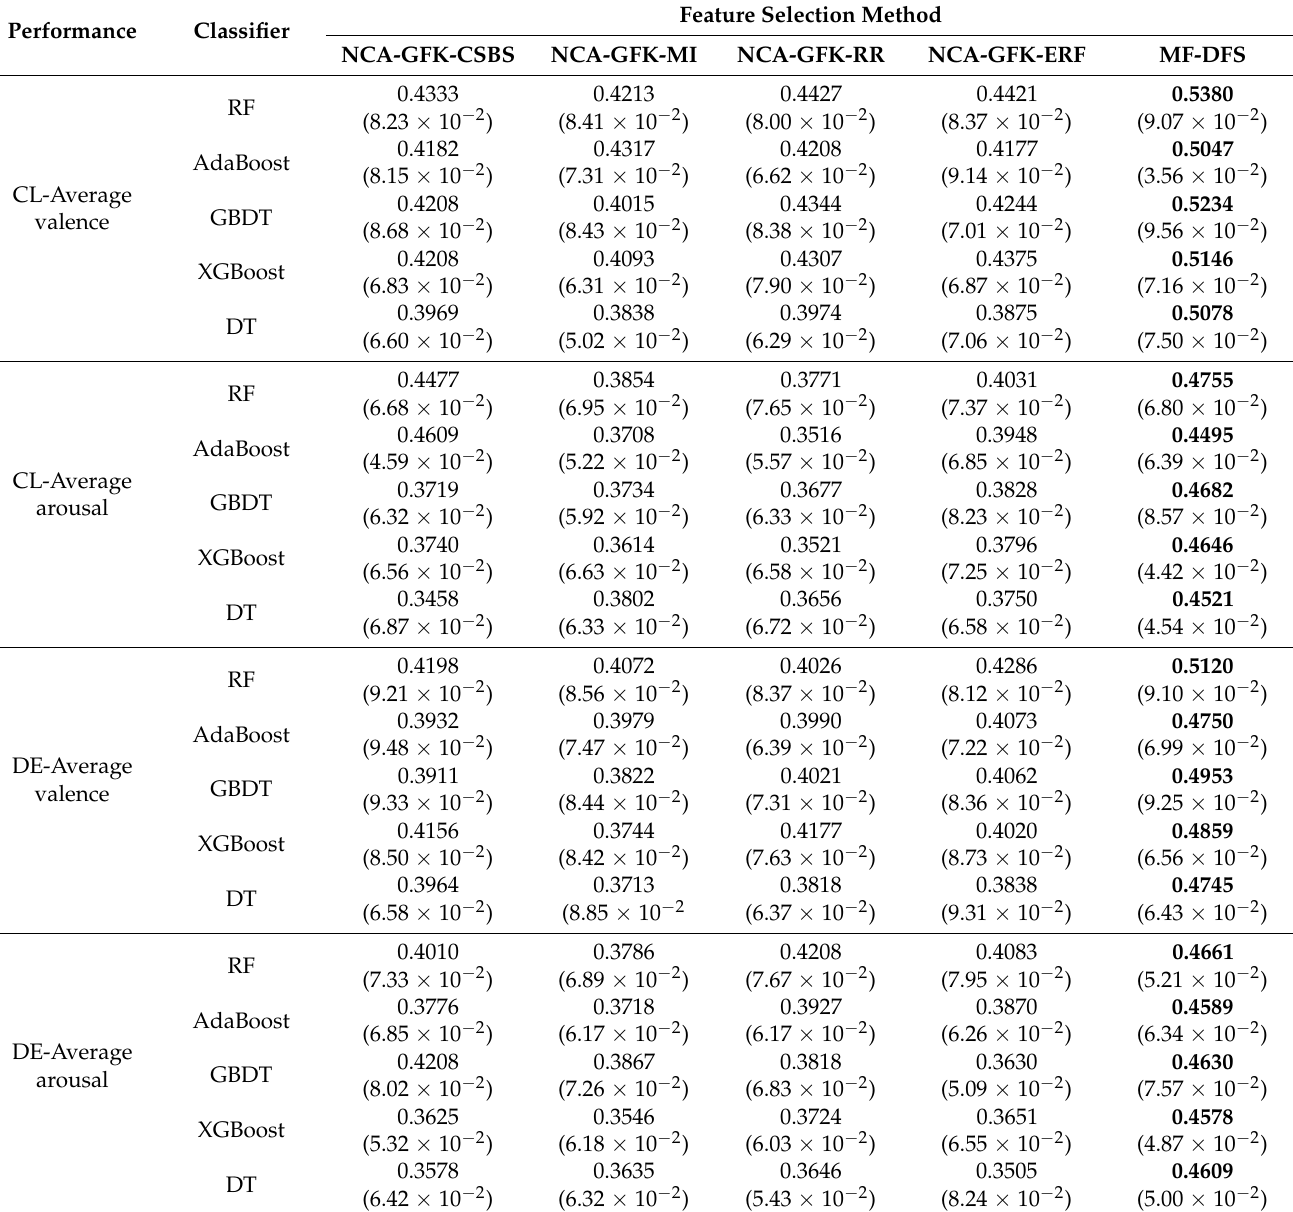
Table 5. Classification performance comparison across different combinations of feature selection methods and machine learning classifiers on the MAHNOB-HCI